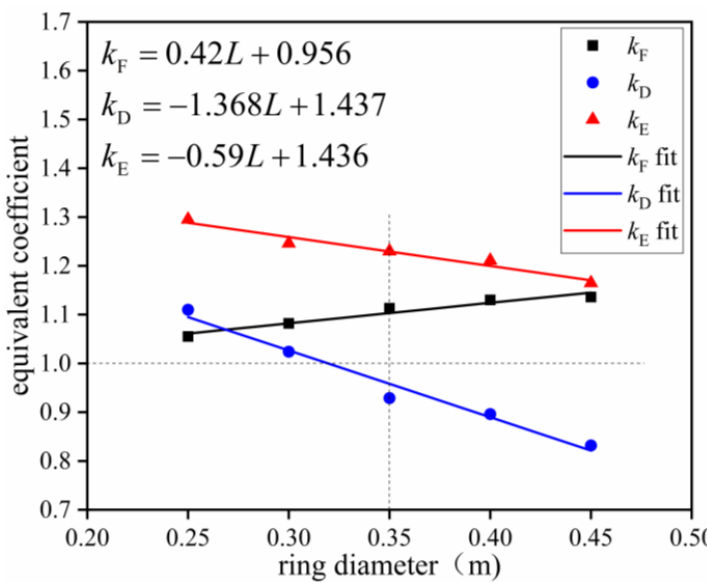
Figure 17. Equivalent coefficients at different ring diameters